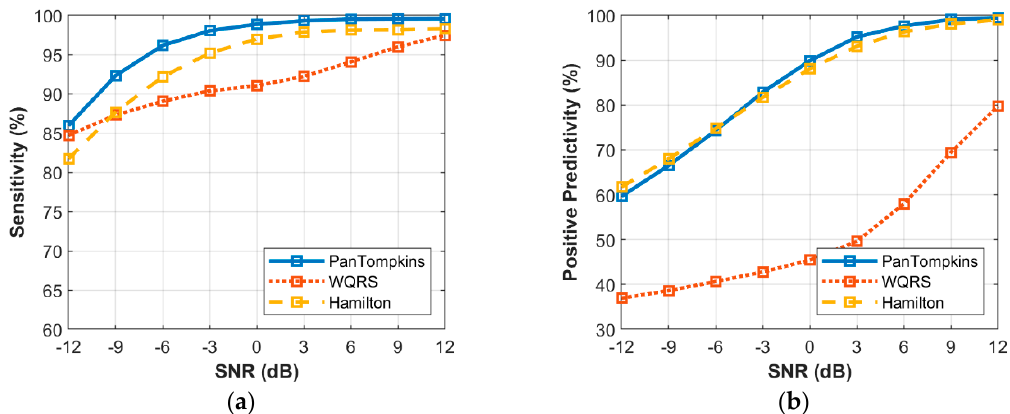
Figure 13. Relationship between the performance of beat detection and MA for all the 48 records: ( a ) sensitivity with SNR; ( b ) positive predictivity with SNR.